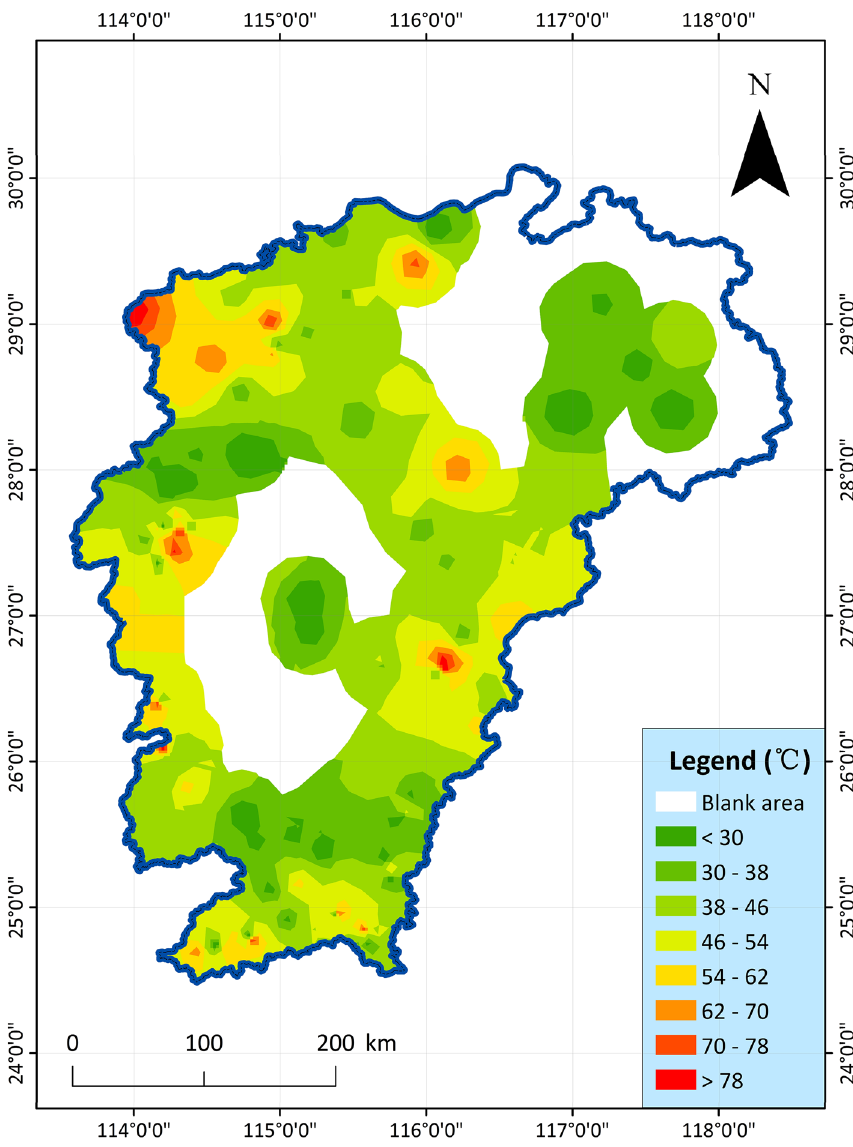
Figure 3. The temperature distribution map of naturally exposed hot springs or geothermal well water in Jiangxi Province 47